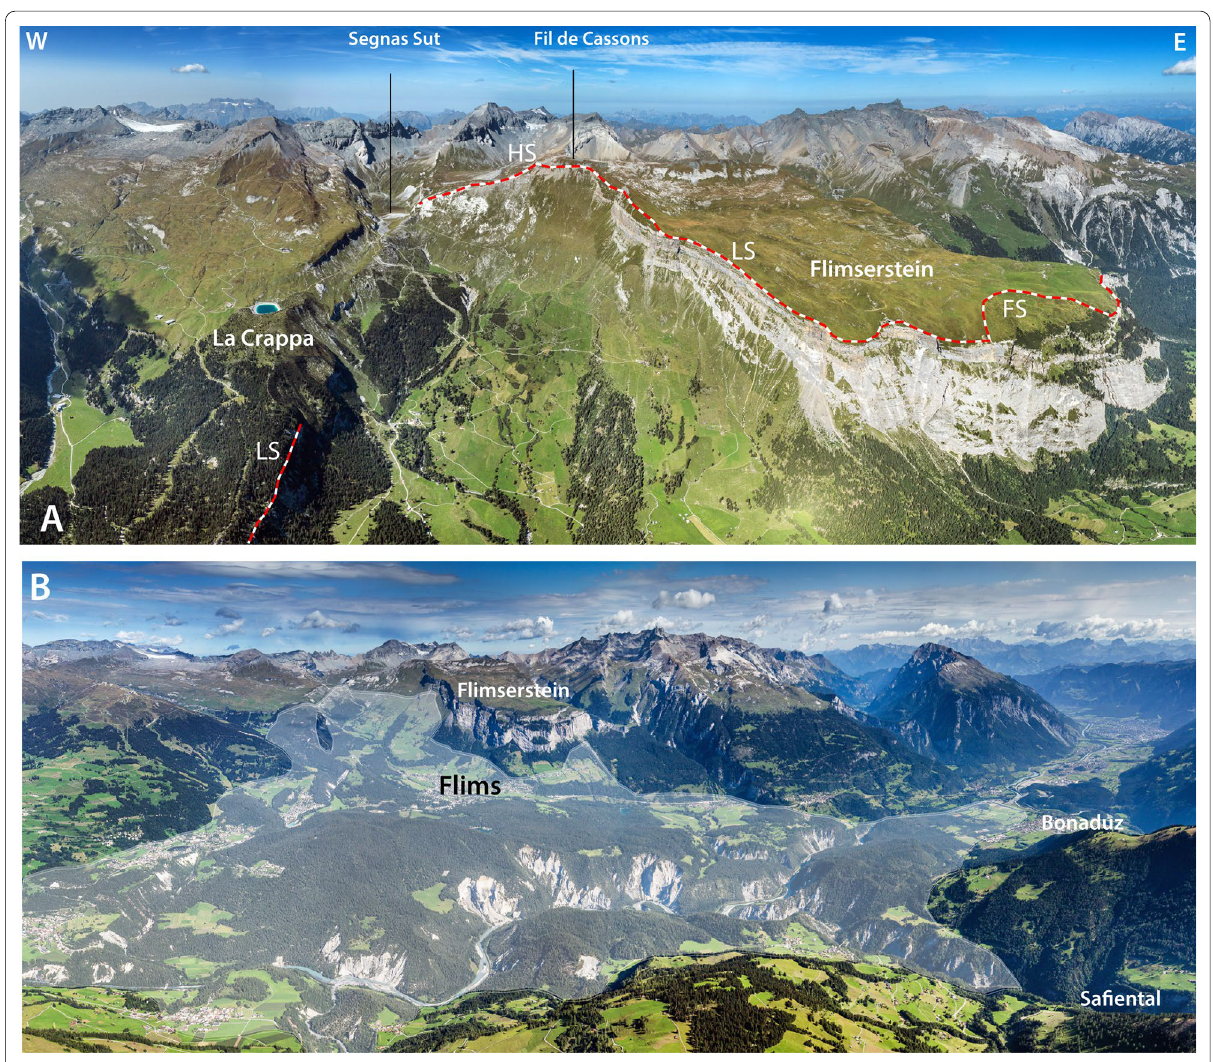
Fig. 4 Overall view of the Flims rock avalanche. A Flimserstein with the scarps left behind by the Flims rock avalanche. View is to the north. FS, HS, LS: Frontal, Head, Lateral scarp. Photo © Tektonikarena Sardona/R. Homberger. B View to the north across the Vorderrhein valley. The extent of the rock avalanche deposit is colored faintly in white. Photo ©Tektonikarena Sardona/R. Homberger. C The photograph shows the head scarp between Fil de Cassons and Segnas Sut. View is to the east. Two klippen of Verrucano (V) sit on top of Flimserstein. The planar slope to the right (south) of the head scarp is the gliding surface in the zone of depletion. Photo A.